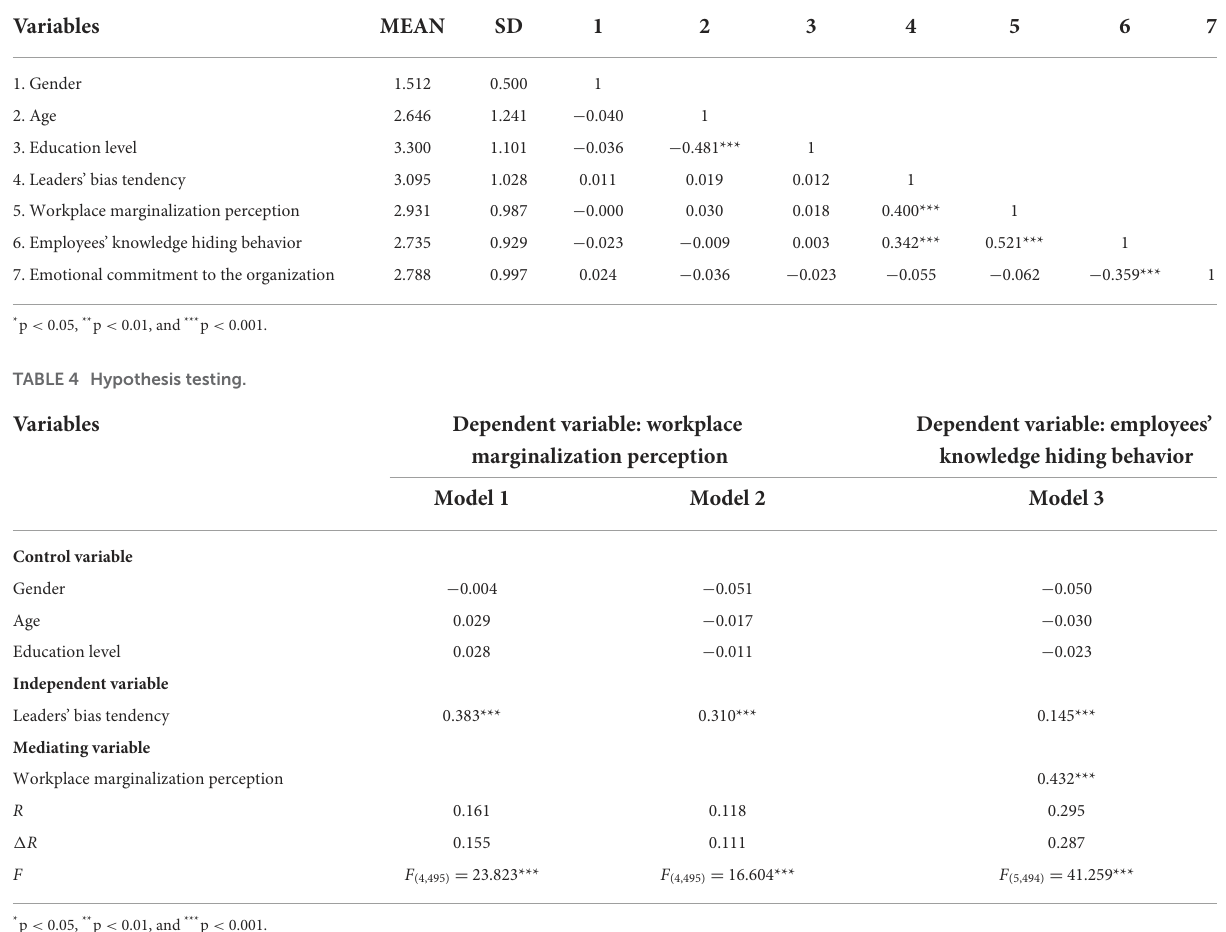
TABLE 3 Results of descriptive statistical analysis.